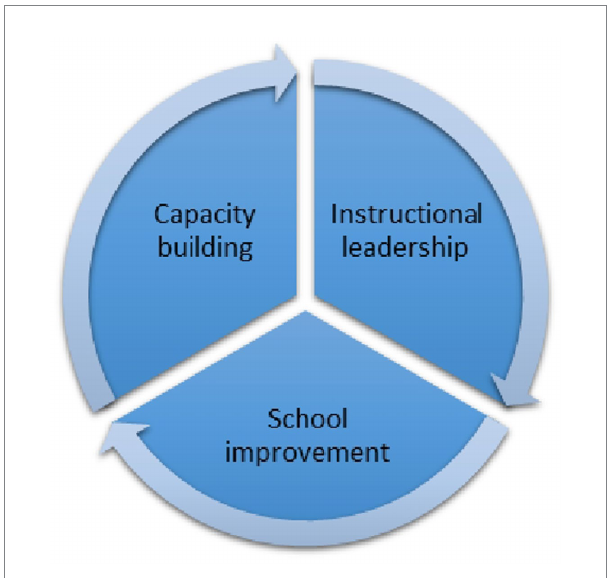
FIGURE 2 Cycles of learning within VPLC emerging from participants’